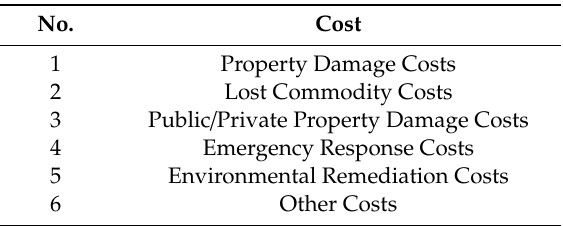
Table 2. Constitution of the cost of each failure event.